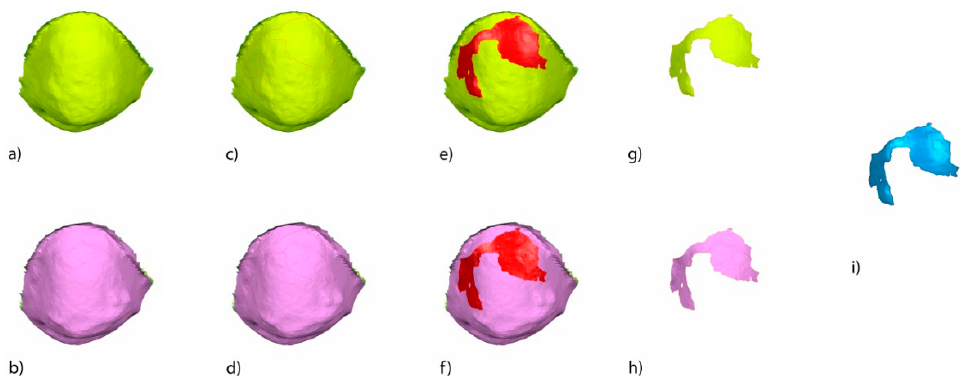
Figure 7. Palatal perspective of tooth 1.5 segmented on STL1 ( a ) and STL4. ( b ) Slight over-contouring of STL1 ( c ) and STL4. ( d ) Boundary of the enamel removed from STL1 ( e ) and STL4. ( f ) Mesh of the enamel removed from STL1 ( g ) and STL4 ( h ) and the combined meshes with the enamel removed after polishing STL1 and STL4, obtaining a closed polygon ( i